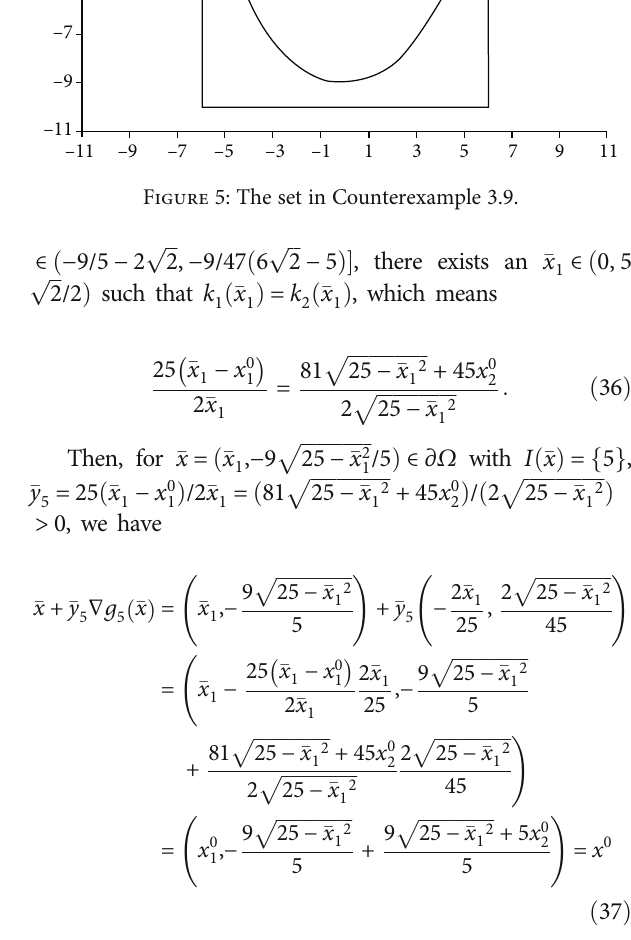
ffiffiffi p 2 /2 Þ 5 2 ð